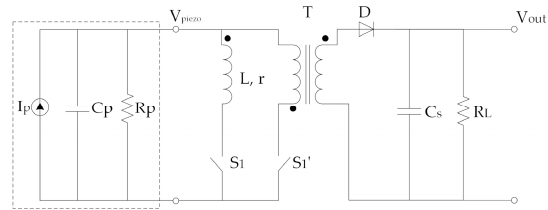
Figure 49. The MR-SSHI rectifier circuit.